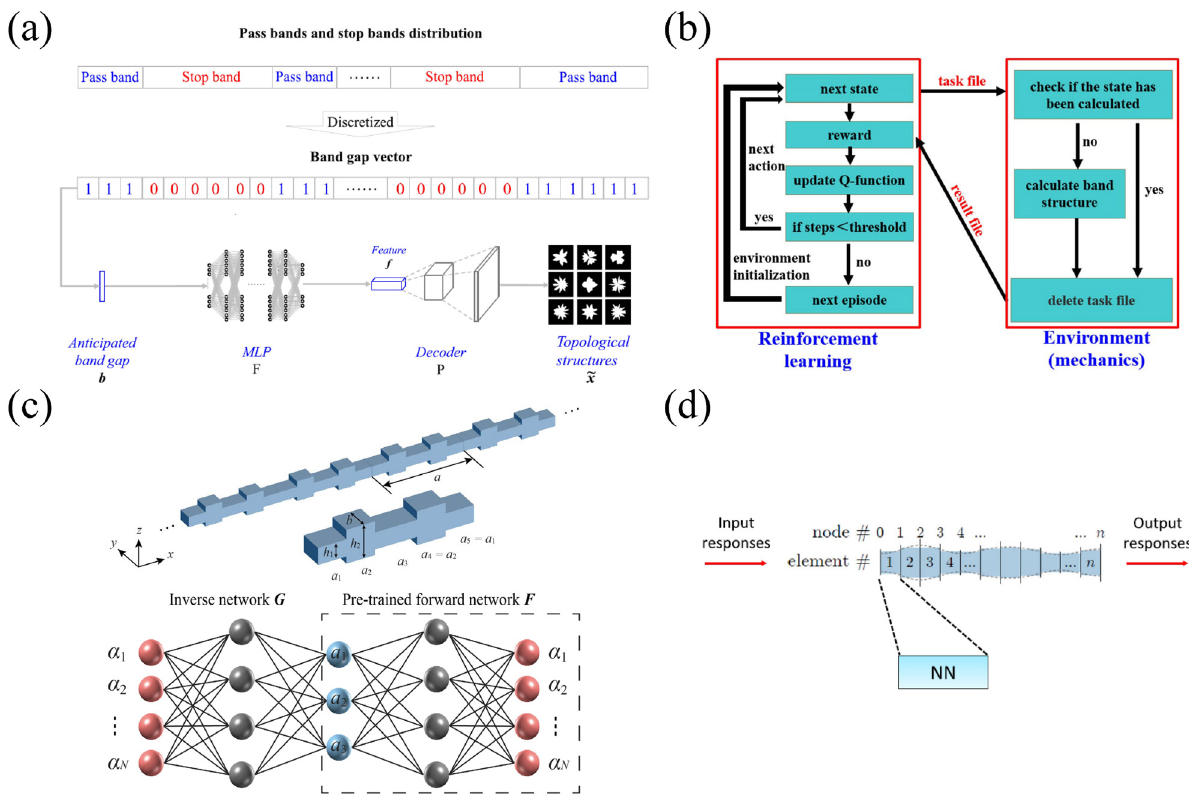
Figure 8: Elastic metamaterials design enabled by advanced neural network model and reinforcement learning. (a) Design of phononic crystals by AE and MLP. The MLP link the band information and geometric characteristics of structures, while the decoderisemployedtoreconstructthestructures[122].(b)Designoflayeredphononiccrystalswithspeci fi cbandstructuresbyreinforcement learning[123].(c)Designofphononicbeamswithspeci fi cbandgapwidthandtopologicalpropertiesbyreinforcementlearningandTNNs[124]. (d) Simulation of the structural units using neural networks